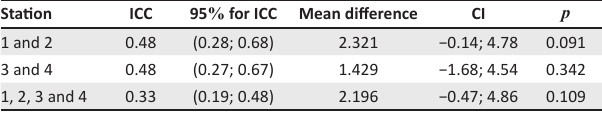
TABLE 4: Inter-station reliability (Reading 1).